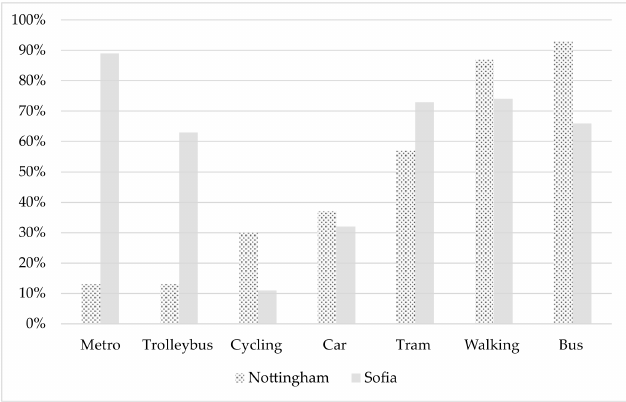
Figure 17. Preferences of modes of transport by the trial participants.